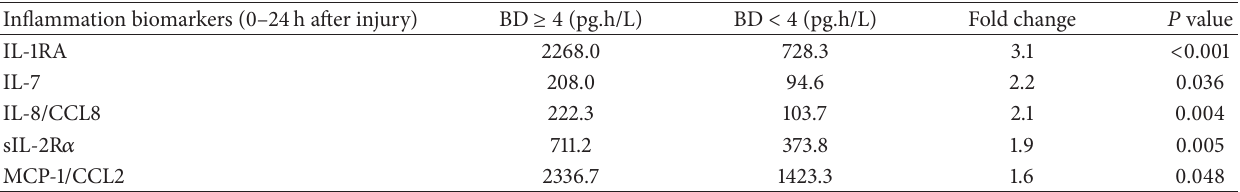
Table 2: Summary of the area under the curve (AUC) analysis in the first 24 h after injury for statistically significantly different inflammatory mediators (by two-way ANOVA) between the BD < 4 and BD ≥ 4 subgroups. Inflammation biomarkers (0–24 h after injury) BD ≥ 4 (pg.h/L)